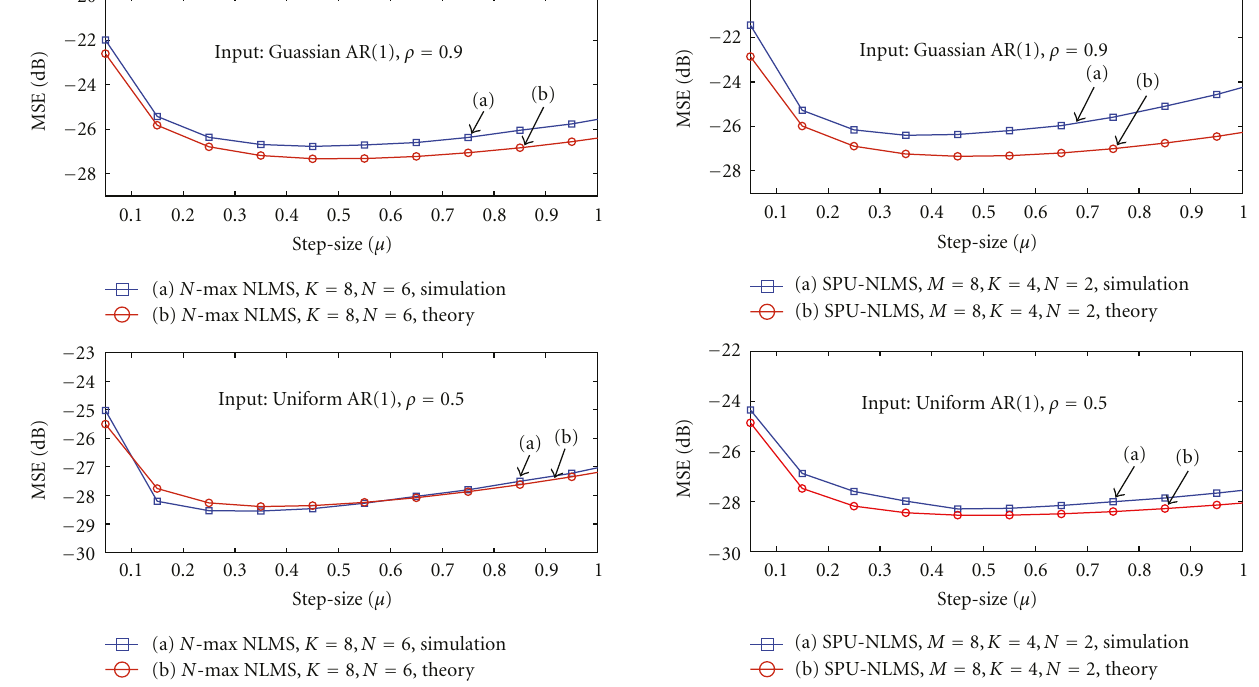
Figure 6: Steady-state MSE of SPU-NLMS with M = 8, K = 4 and N = 2 as a function of the step size in nonstationary environment for di ff erent input